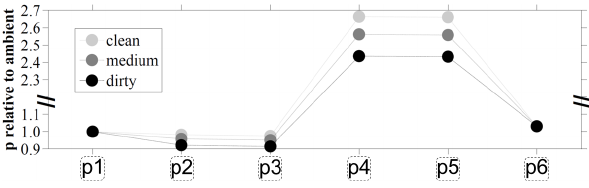
Fig. 4. Pressures measured at positions p1–p6 within the automated Tn and Rn profile system (p1=ambient pressure) during the filter clogging simulation (clean, medium,